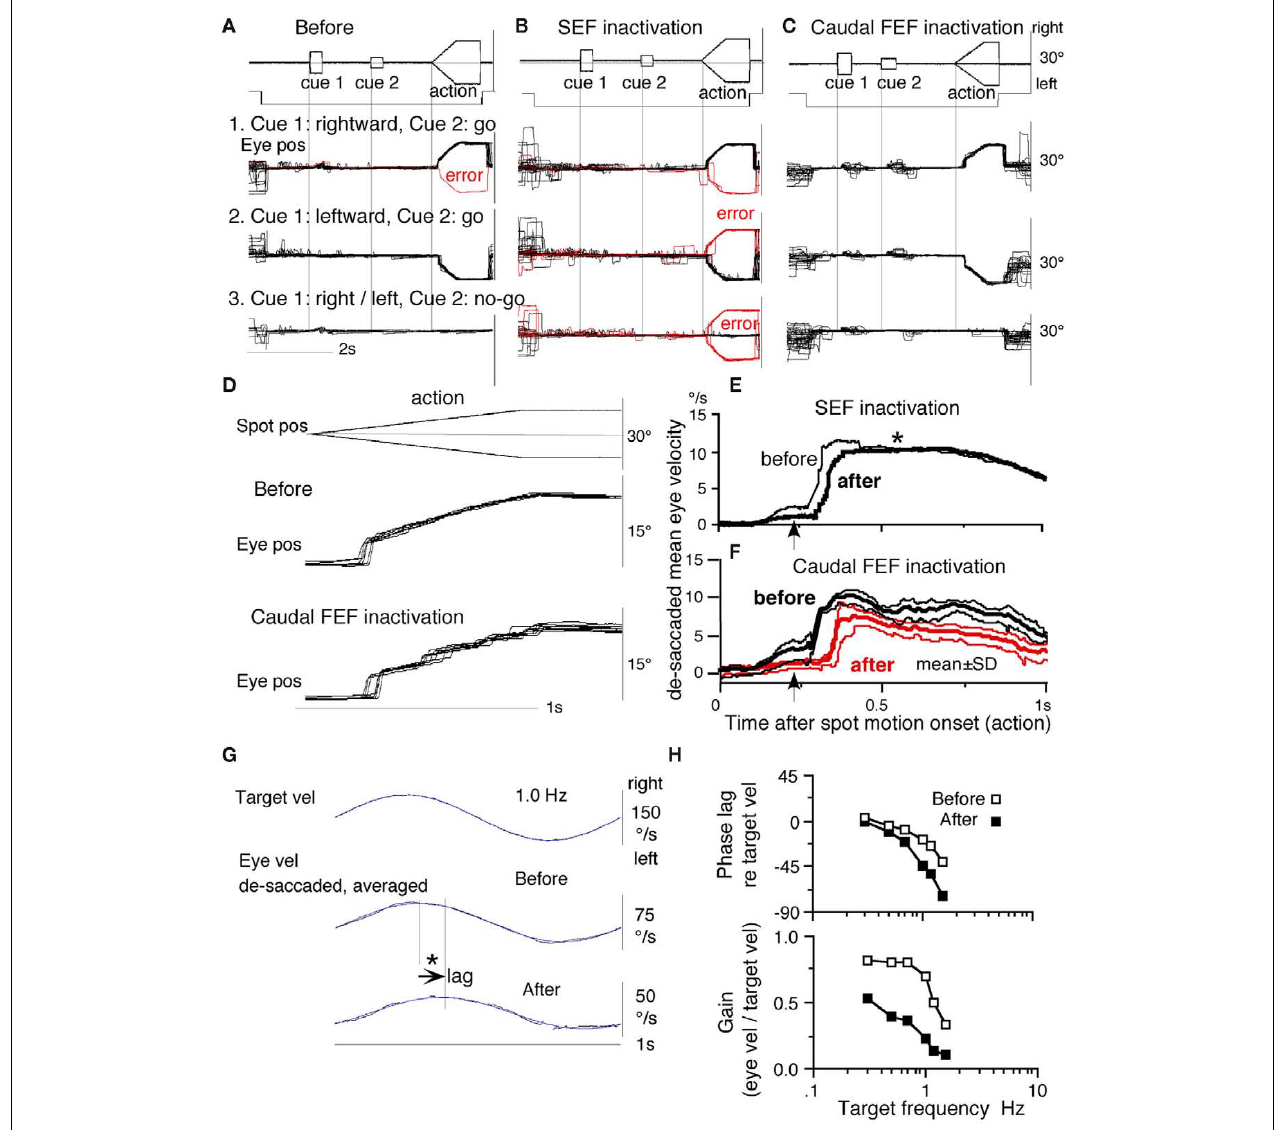
Compares de-saccaded and averaged eye velocity before and after caudal FEF inactivation. Arrow indicates that peak eye velocity lagged after muscimol infusion. (H) Plots phase and gain of eye velocity (relative to target velocity) before (open) and after (filled) caudal FEF inactivation. (A,B,E) Reproduced from Shichinohe et al. (2009) and Fukushima et al. (2011a) with permission. (C,D,F,G,H) Reproduced from Fukushima et al. (2011a,b) with